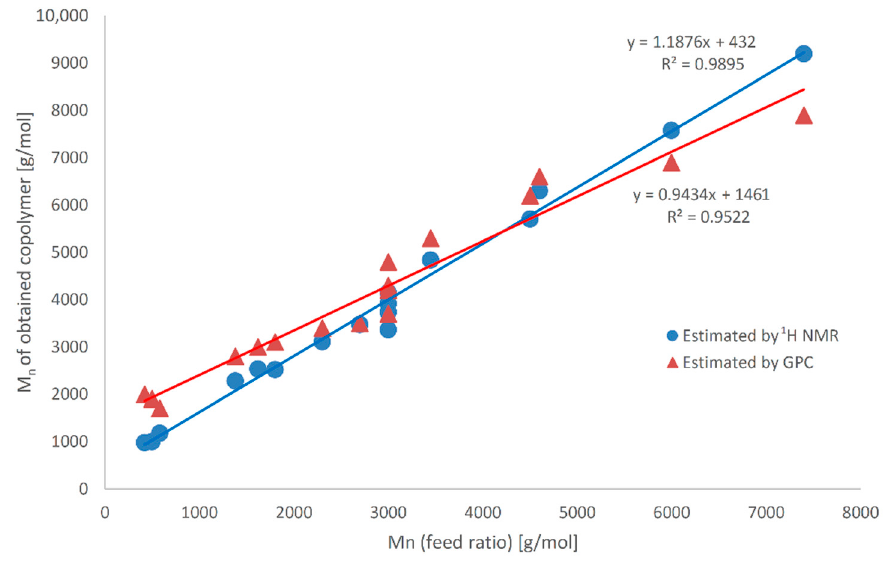
Figure 4. Estimated M n of PCEC versus theoretical M n values calculated from feed ratio.